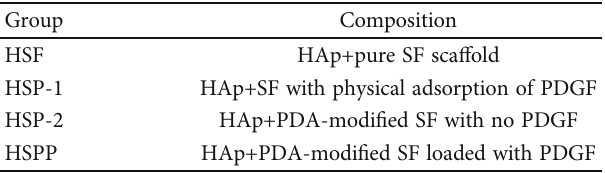
Table 1: Sample abbreviations used in this study.